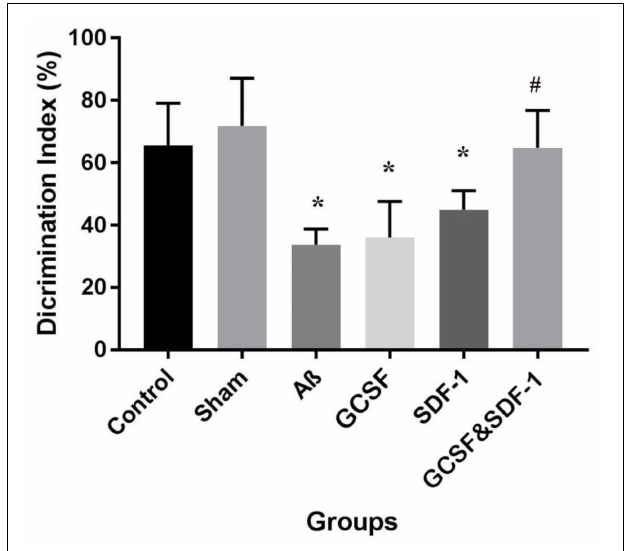
FIGURE 3 | Effect of SDF-1 and G-CSF treatment on discrimination index in object recognition test. (* P < 0.05) as compared with control and sham group. (# P < 0.05) as compared with G-SDF and SDF-1 groups. Each column represents Mean ± SEM.